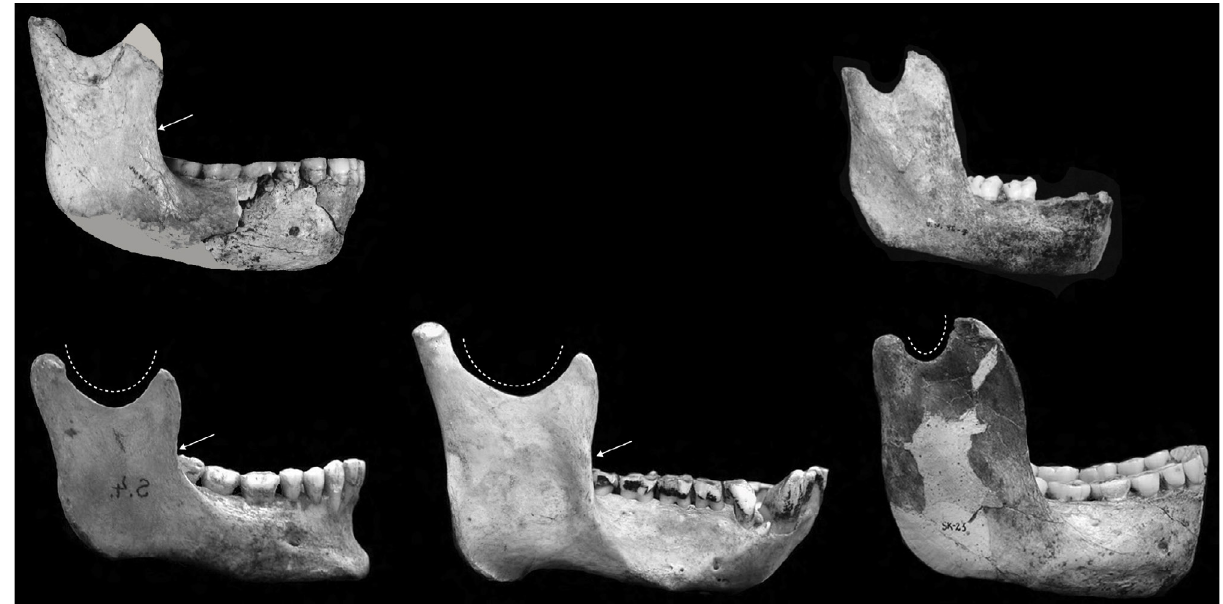
Figure 1: Ramal morphology of five hominoid specimens (not shown to scale). From upper right, clockwise: MH1, Australopithecus robustus (SK 23), orangutan, Homo sapiens and MH2. Note the hook-like shape of the coronoid process and the confined, narrow, and asymmetric mandibular notch in the Australopithecus robustus mandible and the notch’s similarity to that of the MH1 mandible. The upper part of the ramus in all the other mandibles exhibits the generalised configuration. Also note the absence of a preangular notch on the anterior margin of the specialised ramus and the presence of the notch, indicated by white arrows, on the generalised ramus. The photographs of MH1 and MH2 were adapted from Berger et al. 2 and de Ruiter et al. 3 with permission. Note the parts that we added (reconstructed) on